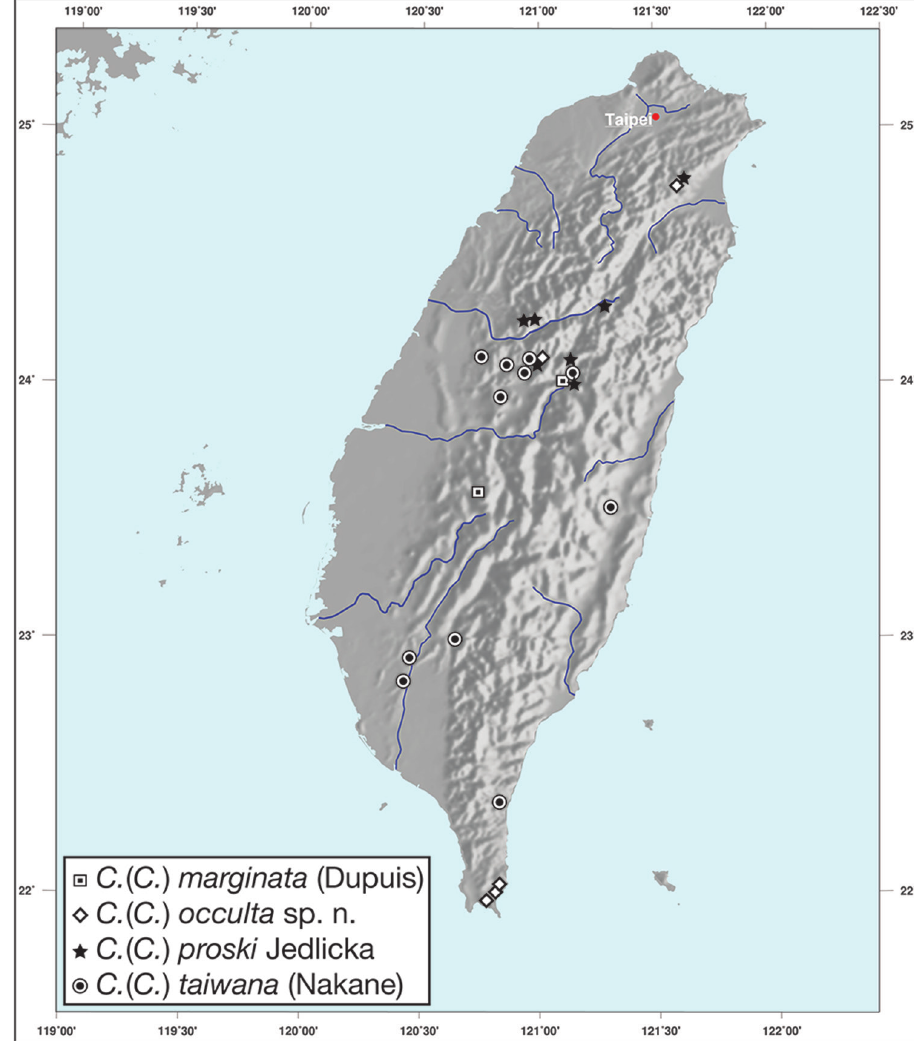
Figure 60. Map showing known localities for species of the genus Coptodera Dejean, subgenus Coptode- rina Jeannel, in Taiwan (in part).